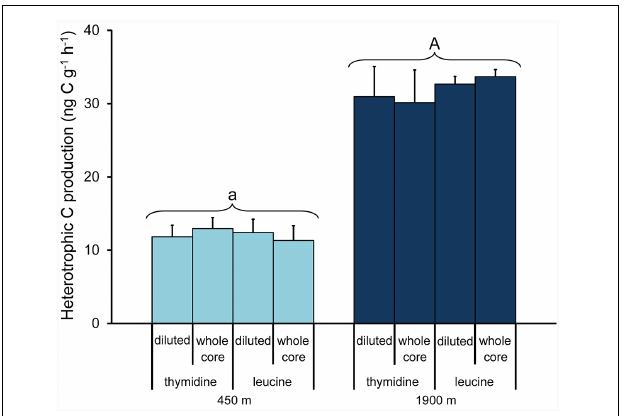
FIGURE 4 | Comparison between prokaryotic heterotrophic carbon production determined by parallel incorporation experiments of 3 H-thymidine or 3 H-leucine carried out on diluted sediments (1:1) and intact sediment cores collected at the two benthic deep-sea sites (at 450 and 1900 m water depth). Mean values ( n = 3) and SDs are reported. The upper case letter “A” for the station at 1900 m indicates